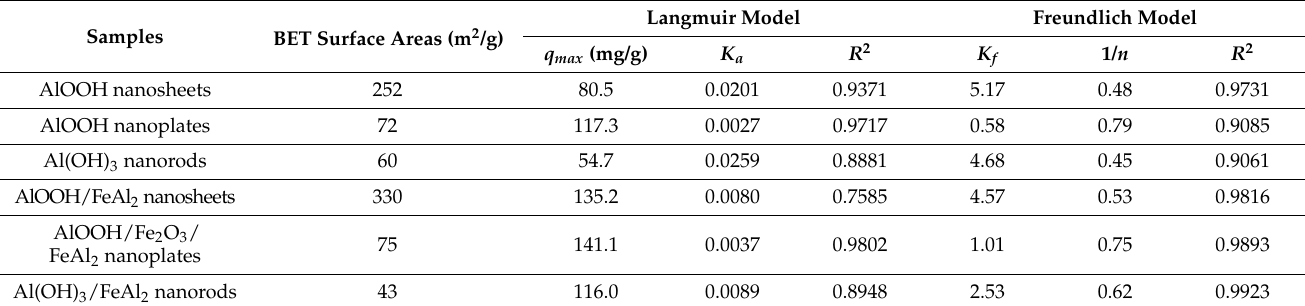
Figure 8. Linearized Langmuir ( a , b ) and Freundlich ( c , d ) adsorption isotherms for Al and Al/Fe nanostructures obtained by the water oxidation of Al ( a , c ) and Al/Fe ( b , d ) nanopowders. 1: Nanosheets; 2: nanoplates; 3: nanorods. Table 1. The Langmuir and Freundlich model